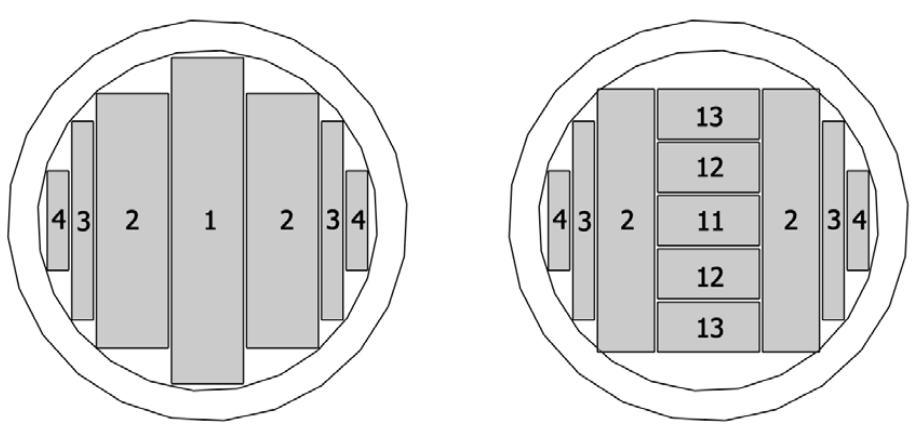
Figure 8. Nominal dimensions of timber.